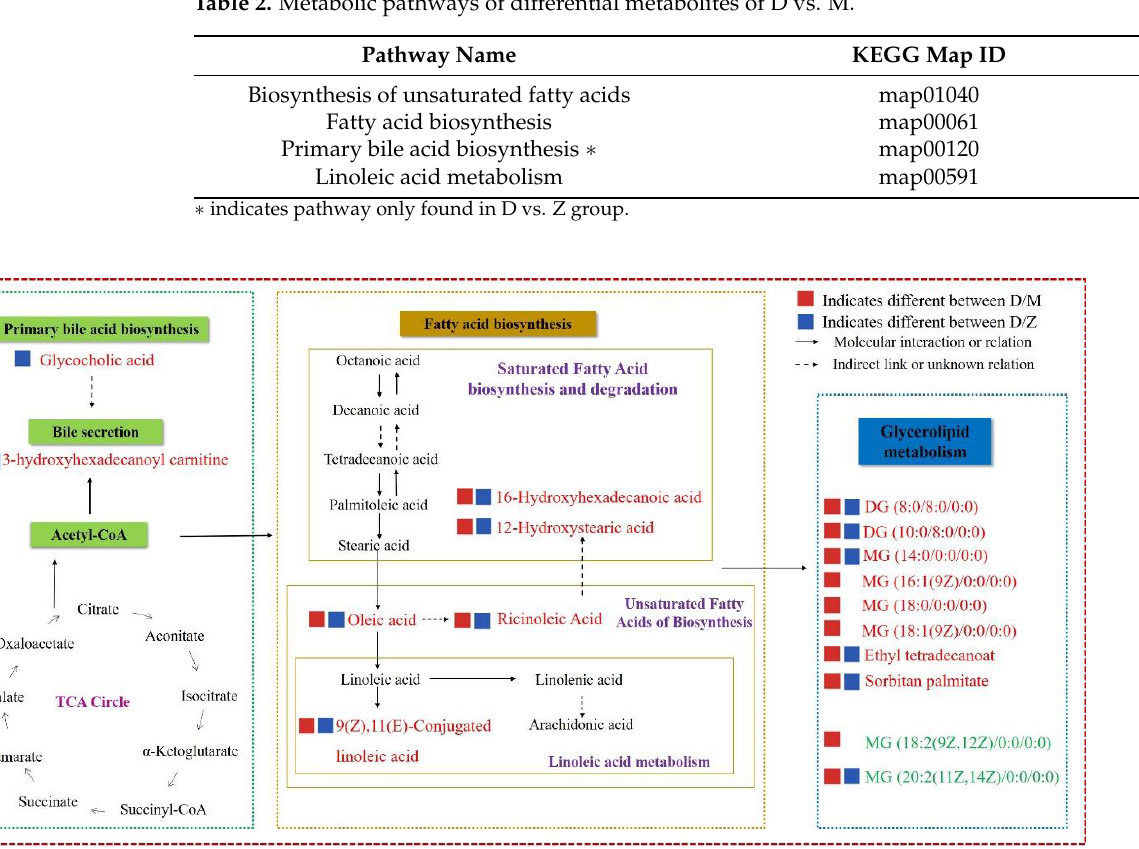
Figure 4. Metabolic network of the potential biomarkers which were different among group D (milk from Mediterranean buffalo), group M (milk from Murrah buffalo), and group Z (milk from crossbred buffalo). The increased metabolites in group D are labeled in red and the decreased metabolites are labeled in green.